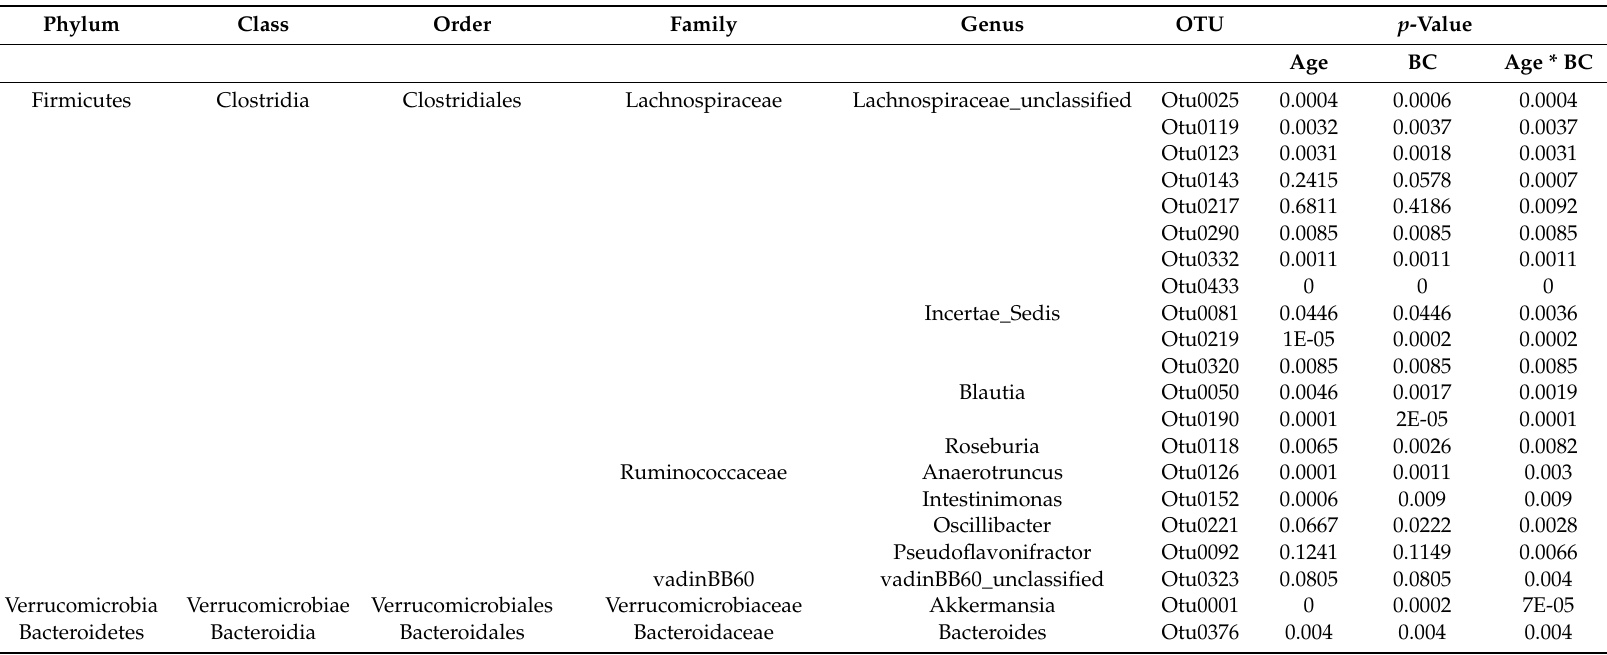
Table 4. OTU abundance showed a significant interaction between age and BC a